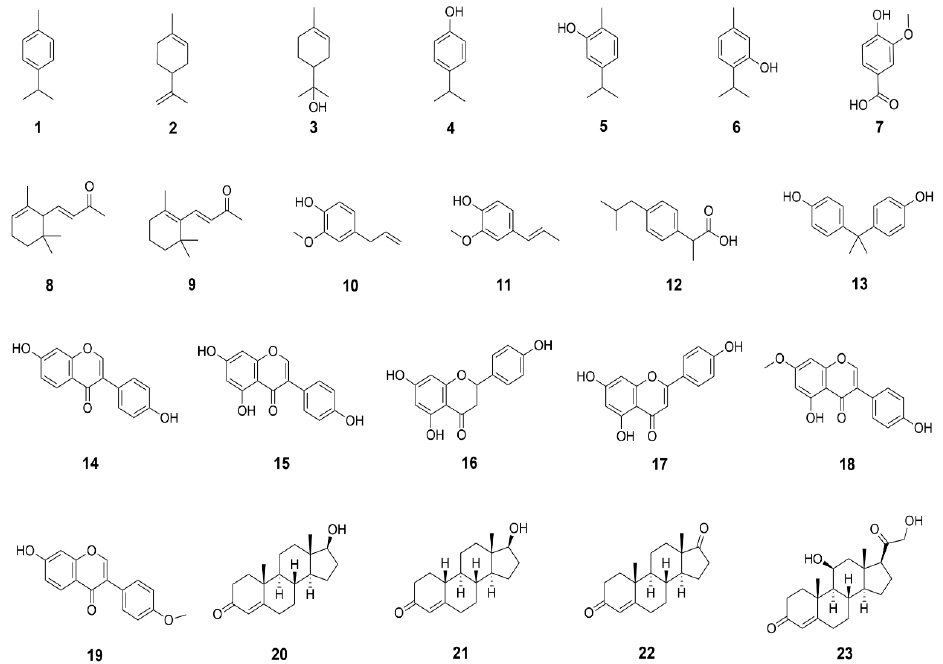
Figure 1. Substrate spectrum of CYP101D5. In vitro biotransformations were performed with purified CYP and Pdx/PdR as redox partners for 2 h using 23 substrates (1, cymene; 2, limonene; 3, α -terpineol; 4, 4-isopropylphenol; 5, carvacrol; 6, thymol; 7, vanillate; 8, α -ionone; 9, β -ionone; 10, eugenol; 11, isoeugenol; 12, ibuprofene; 13, bisphenol A; 14, daidzein; 15, genistein; 16,